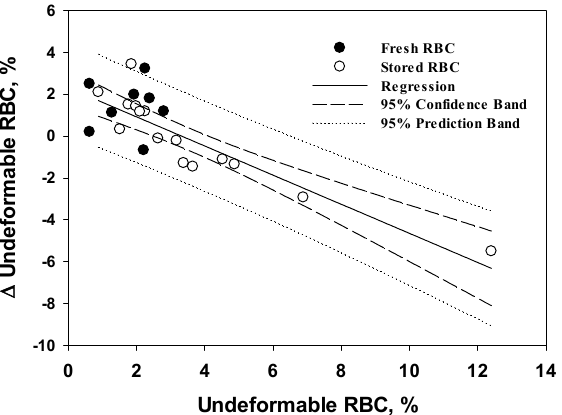
Figure 5. Relationship between Δ UDFC and %UDFC B described by linear regression (r = 0.87; p = 1.4 × 10 − 7 ).